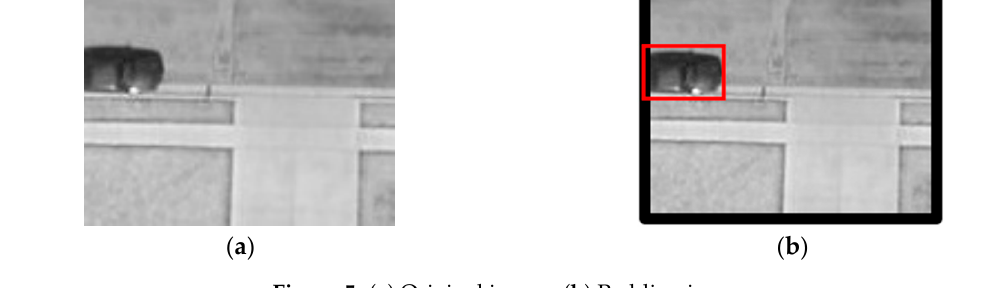
Figure 5. ( a ) Original image. ( b ) Padding image.